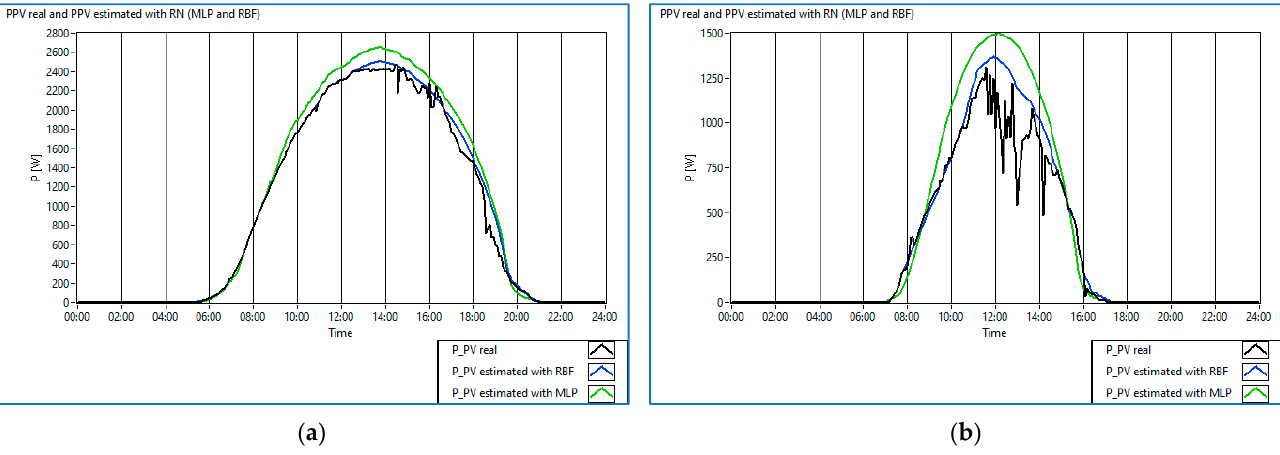
Figure 7. P PV real and P PV estimated using MLP and RBF NN for: ( a ) scenario 1; ( b ) scenario 2.